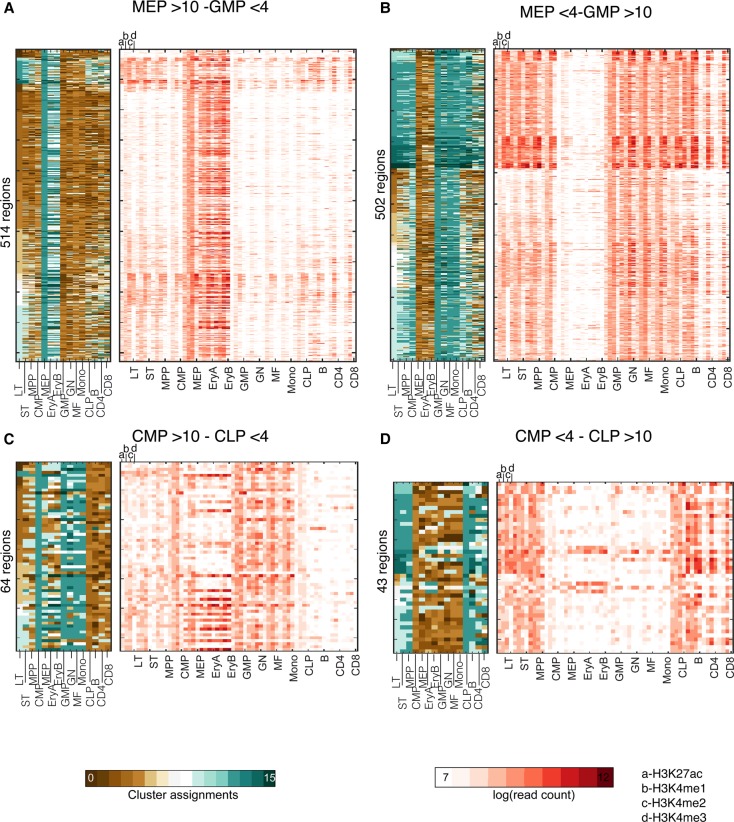
Rule-based analysis of hematopoiesis CMINT modules identifies regions associated with chromatin state transitions at different lineage points. (A, left) Regions that belong to modules enriched for marks (numbered greater than 10) in MEP and depleted for marks (less than 4) in GMP and their module assignments in other cell types. (Right) Histone modification level in the regions that obey the MEP > 10 and GMP < 4 module membership rule. (B) Similar to A, but for regions that obey the GMP > 10 and MEP < 4 rule. (C) As in A, but for regions that obey the CMP > 10 and CLP < 4 rule. (D) As in A, but for regions that obey the opposite rule, CLP > 10 and CMP < 4.